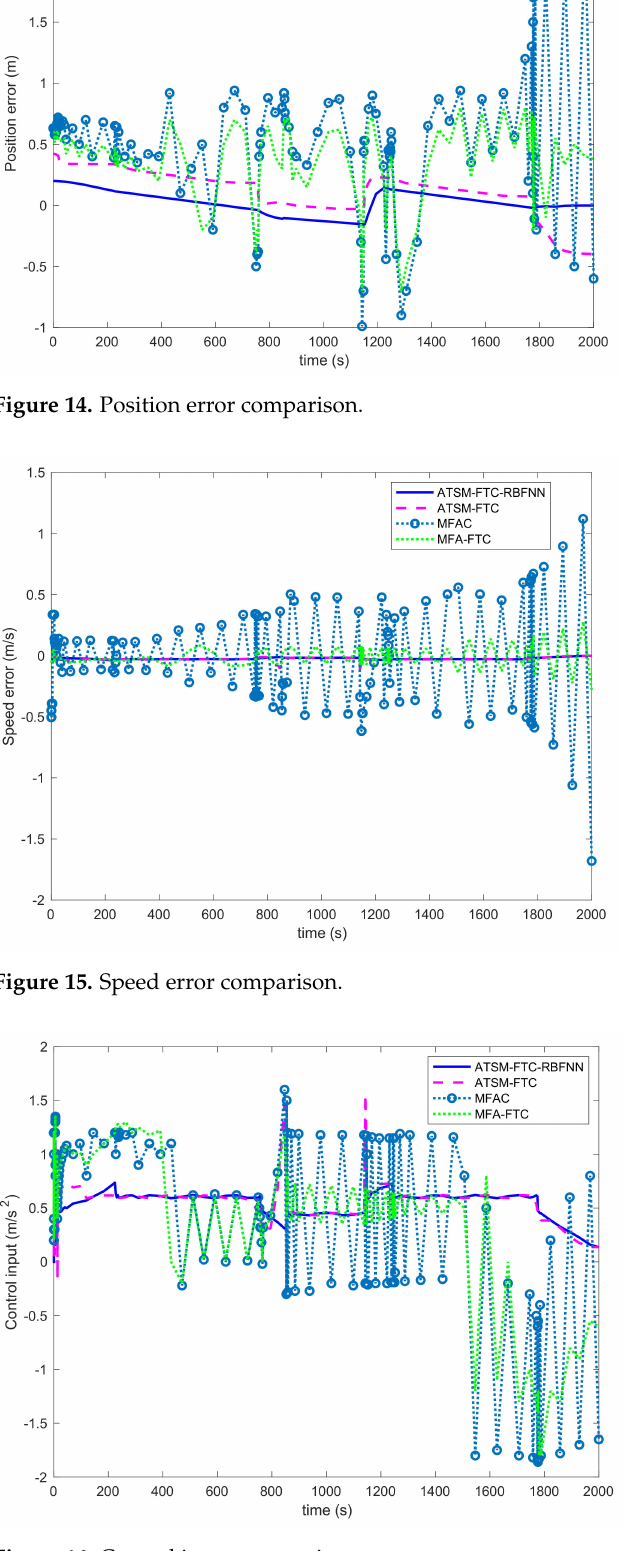
Figure 16. Control input